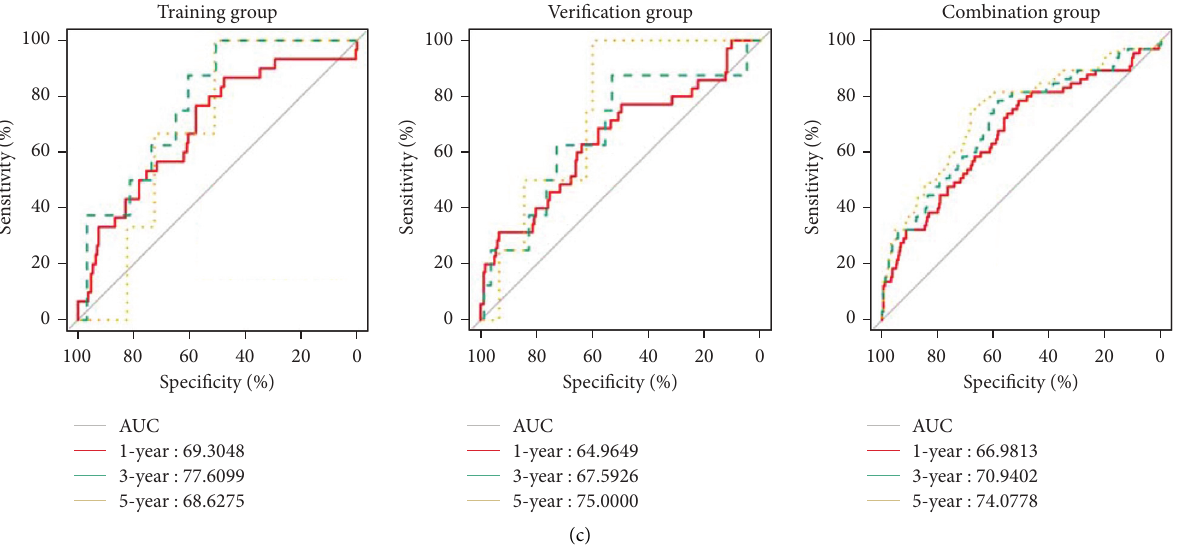
Figure 5: Analysis of a nomogram for predicting OS in EC patients. (a) Nomogram of three independent risk factors (age, FIGO stage, and TPX2); the scores for each variable were added to obtain the total score for predicting the 1-, 3- and 5-year OS of EC patients. (b) Calibration plots for the nomogram of the training group predicting 1- ( n � 217), 3- ( n � 99) and 5-year ( n � 54). The reference line represents a perfect match between the predicted and actual survival probabilities. (c) AUC of the ROC curve verifying the prognostic accuracy of the no- mogram for predicting 1-, 3- and 5-year OS. OS: overall survival; EC: endometrial cancer; AUC: area under the curve; ROC: receiver operating